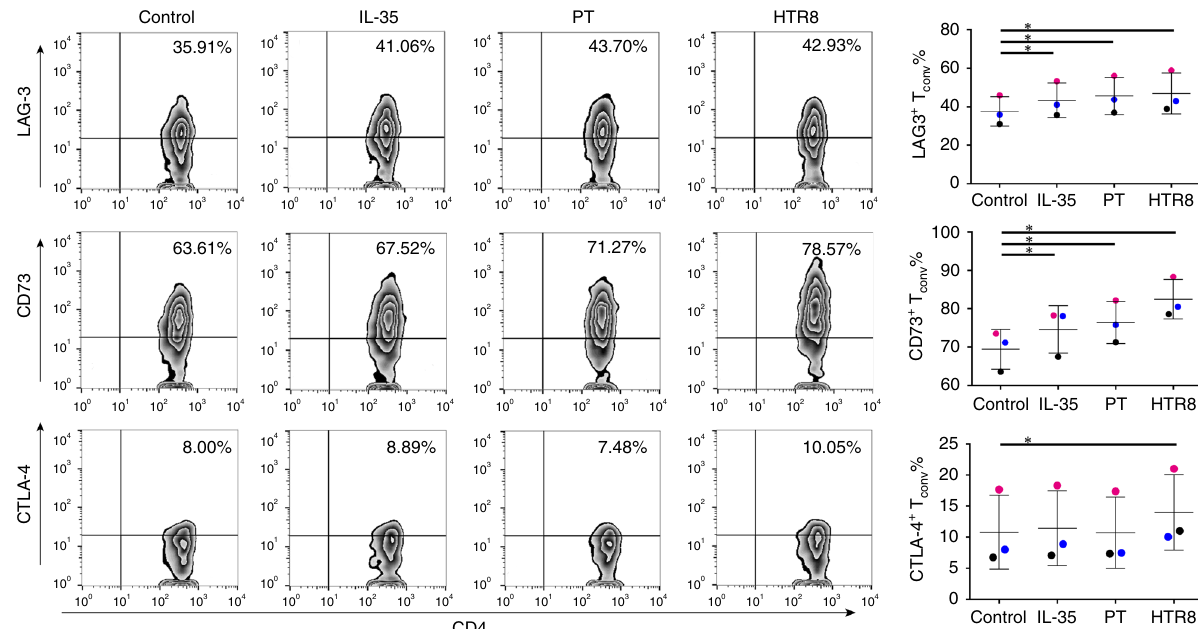
Fig. 3 Inhibitory phenotypic analysis of trophoblast cells-induced iT R 35 cells. T conv cells were cultured in medium alone, or with IL-35 or supernatant from trophoblast cells for 5 days. Then cells were harvested for fl ow cytometry analysis to detect the surface molecules including CTLA-4, CD73, and LAG-3. Density plots showing percentages of CTLA-4 + , CD73 + , and LAG-3 + cells among T conv cells (left) and the corresponding statistical analysis (right) ( n = 3). Data were represented as mean ± SD. Signi fi cance was determined by paired Student ’ s t test analysis. * P <